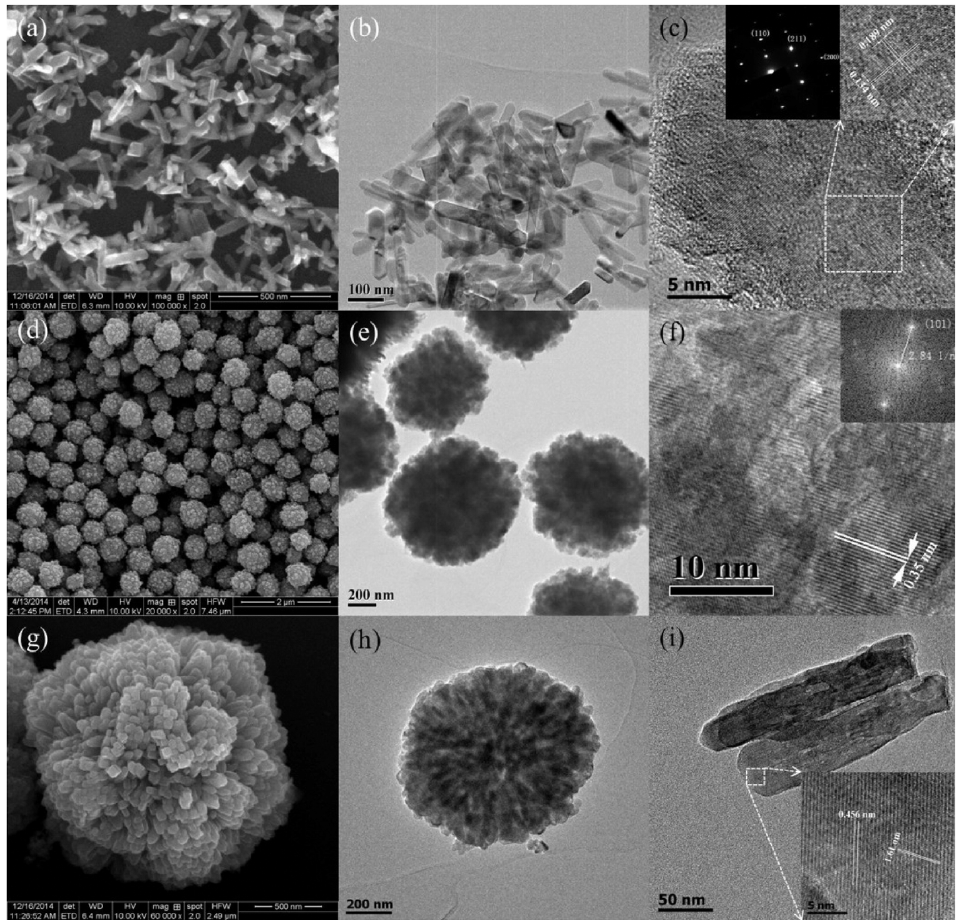
Figure 22. SEM and TEM characterizations of TTIP/OA samples with varied ratios: ( a – c ) 2:1, ( d – f ) 1:3, and ( g – i ) 1:6. Reprinted from [83].